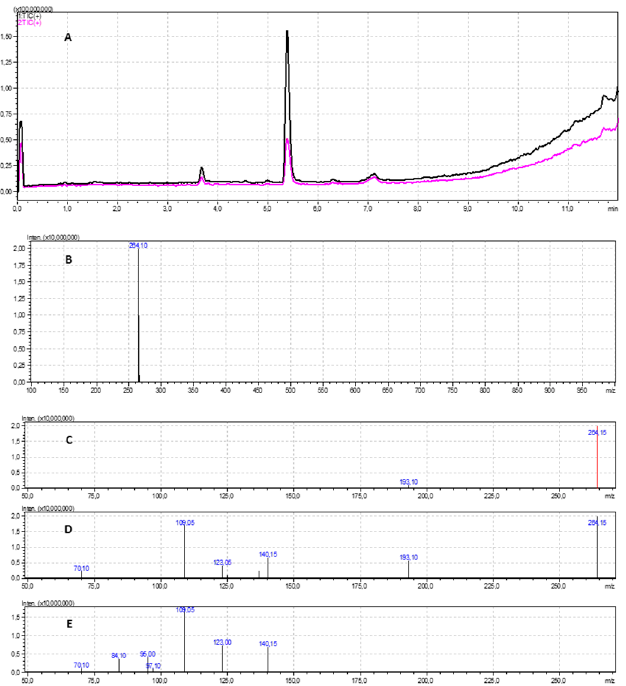
Figure 16. Total ion chromatogram (TIC) of the sample with 4F-PHP ( 3 ) and IS ( A ); mass spectrum of the precursor ion ( B ) and the Product Ion Scan with collision energy: − 10 V, − 20 V and − 35 V, respectively ( C – E ).